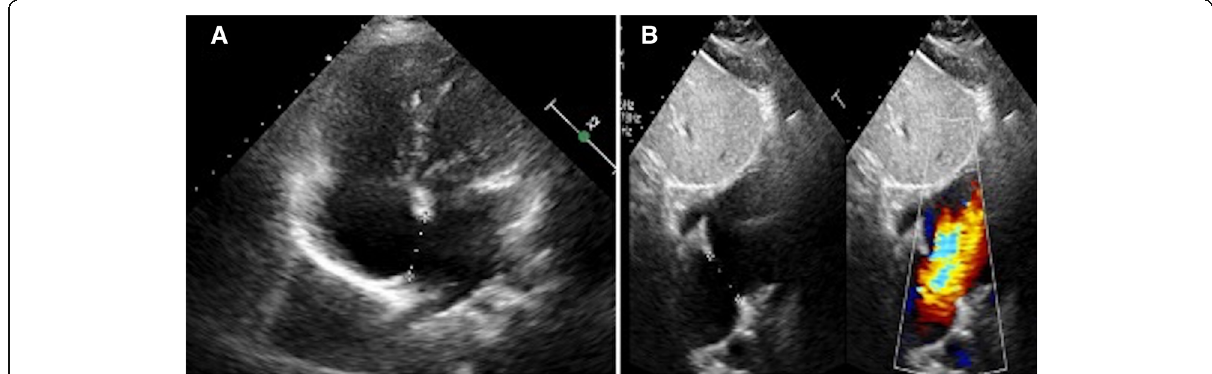
Fig. 3 Transthoracic echocardiogram showing an 18-mm Secundum atrial septal defect with dilated Right atrium and right ventricle ( A ) and left- to-right flow across the defect ( B